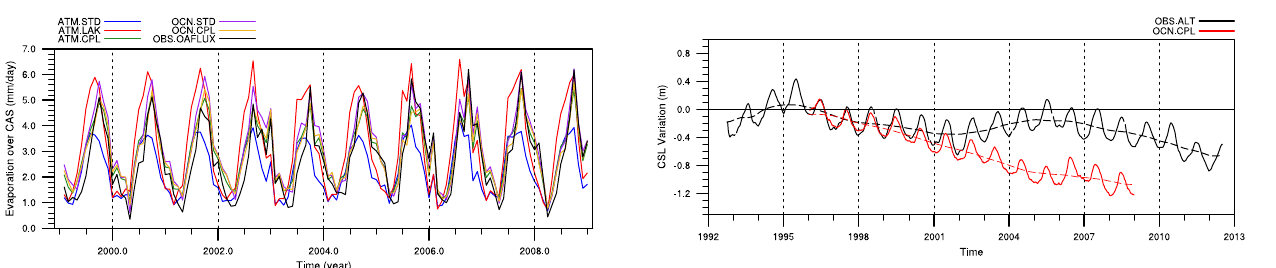
Fig. 14. Time series of monthly evaporation (mmday − 1 ) over CAS of modelled and observed (OAFlux) for the period 1999–2008.